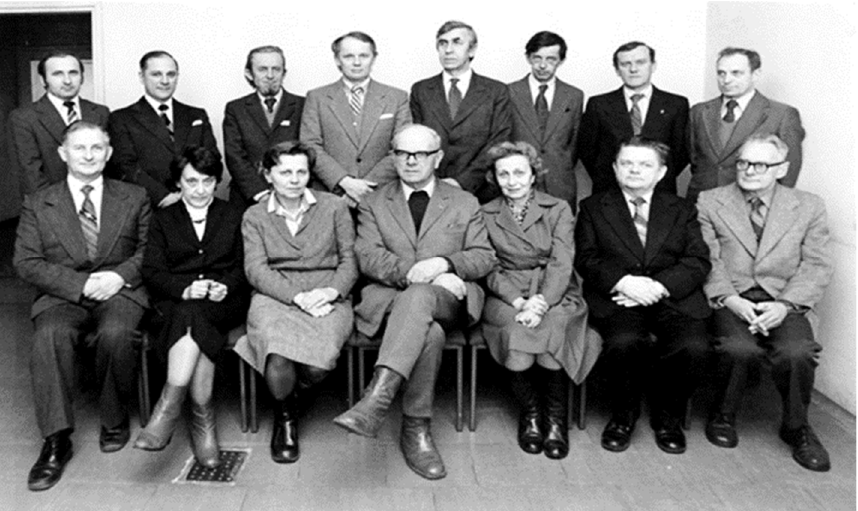
Figure 5. Lublin School of Chromatography created by Prof. A. Waksmundzki (first row, central position). In the photo, the top row from the left: M. Jaroniec, J.K. Ró ż y ł o Z. Suprynowicz, W ł .